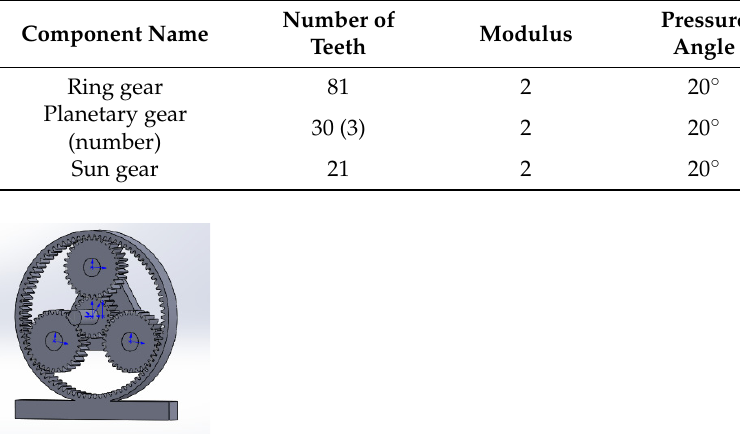
Figure 1. Complete assembly model.